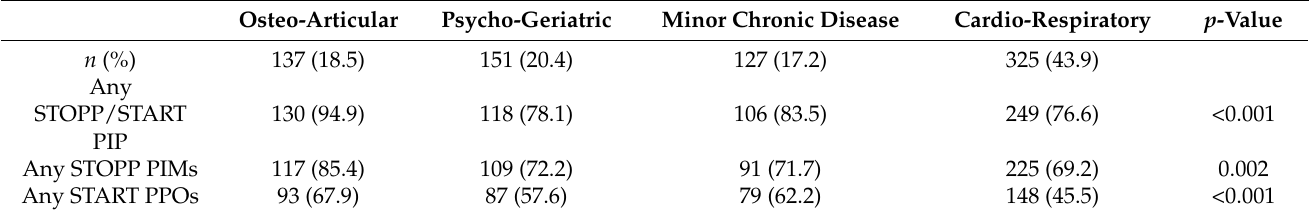
Table 2. Presence of any PIP, PIMs or PPOs according to STOPP/START criteria in relation to the assigned multimorbidity